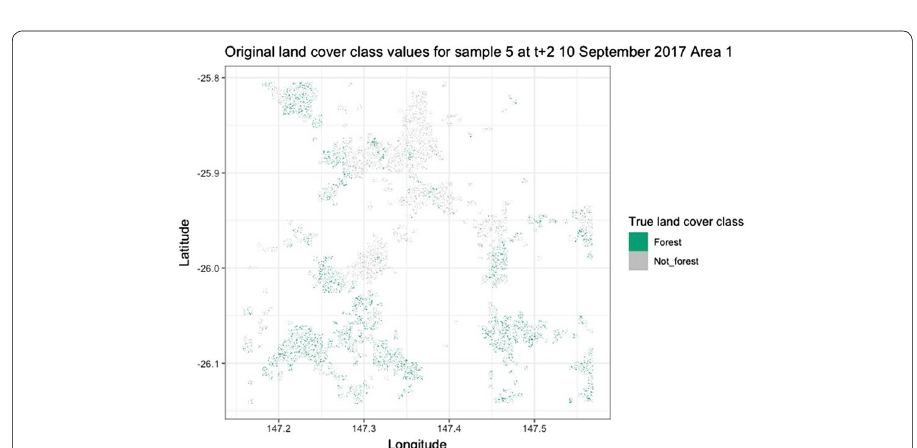
Fig. 7 True classifications of land cover plotted by spatial coordinates. Green indicates forest and grey indicates not